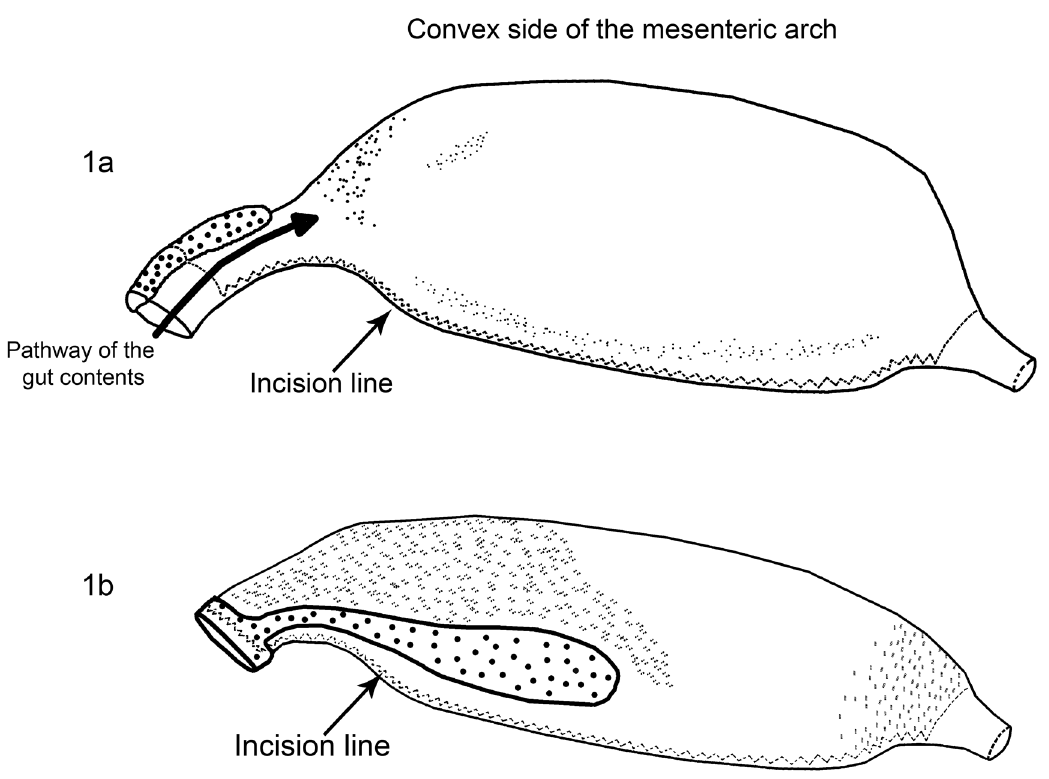
Figure 1. First proctodeal segment (P1), diagrammatic illustrations showing the line of incision most often used in this study. (a) Silvestritermes euamignathus , mesenteric tongue and ornamentation situated on convex side of mesenteric arch; (b) Rhynchotermes nasutissimus , ornamentation situated on convex side of mesenteric arch and mesenteric tongue twisted.